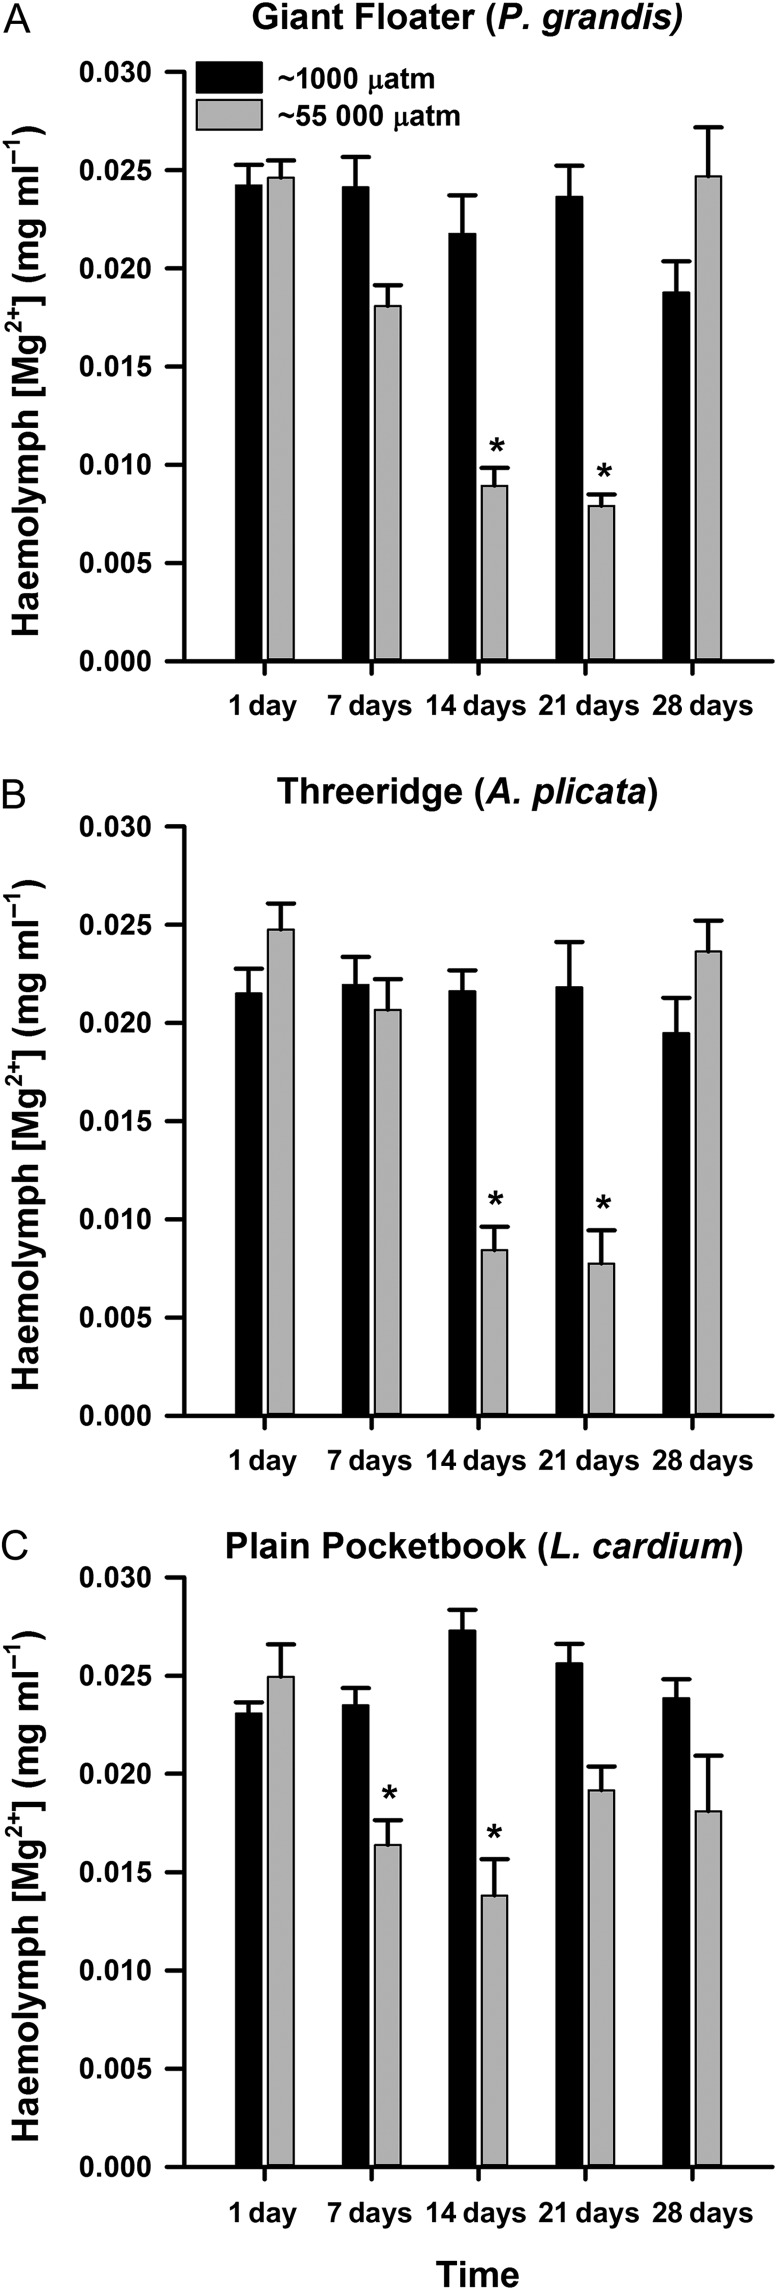
Concentrations of Mg2+ in the haemolymph of Pyganodon grandis (n = 9–14; A), Amblema plicata (n = 12–14; B) and Lampsilis cardium mussels (n = 13–14; C) exposed to two treatments of pCO2, ~1000 µatm (control) or intermittent increase at ~55 000 µatm for 1, 7, 14, 21 or 28 days. Data are presented as means + SEM. *Groups that were significantly different from the control treatment within a time point (two-way ANOVA; see Tables 2–4).